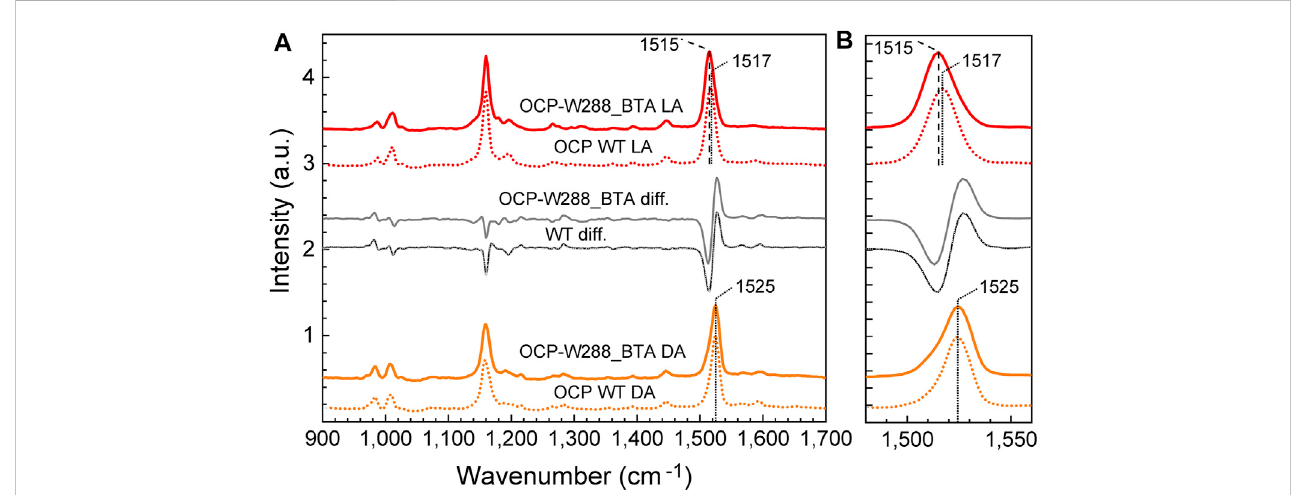
FIGURE 6 Resonance Raman spectra of wild-type OCP and the OCP-W288_BTA variant inthe dark-adapted and illuminated states. (A) Resonance Raman spectra of wild-type OCP (dotted curves) and the OCP-W288_BTA variant (solid curves) in the dark-adapted (DA, orange curves) and light-adapted (LA, red curves) states.Thepeakwavenumbersofthe ν 1 bandareindicated.ThegreycurvesshowthedifferencespectraDAminusLA.Theregionofthe ν 1 -bandisshownin (B) at higher magni fi cation. All dark- and light-matched spectra were intensity normalized based on the amplitude of the ν 1 -band and vertically offset for